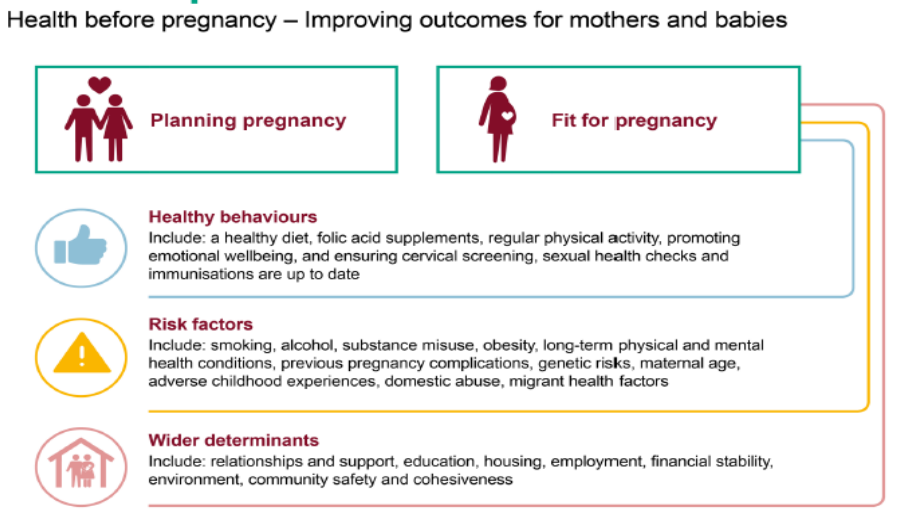
Figure 1. Preconception Health. Influencing factors in the health of mother and children. Public Health England. Planning for pregnancy to improve maternal and child outcomes (2018: 13).